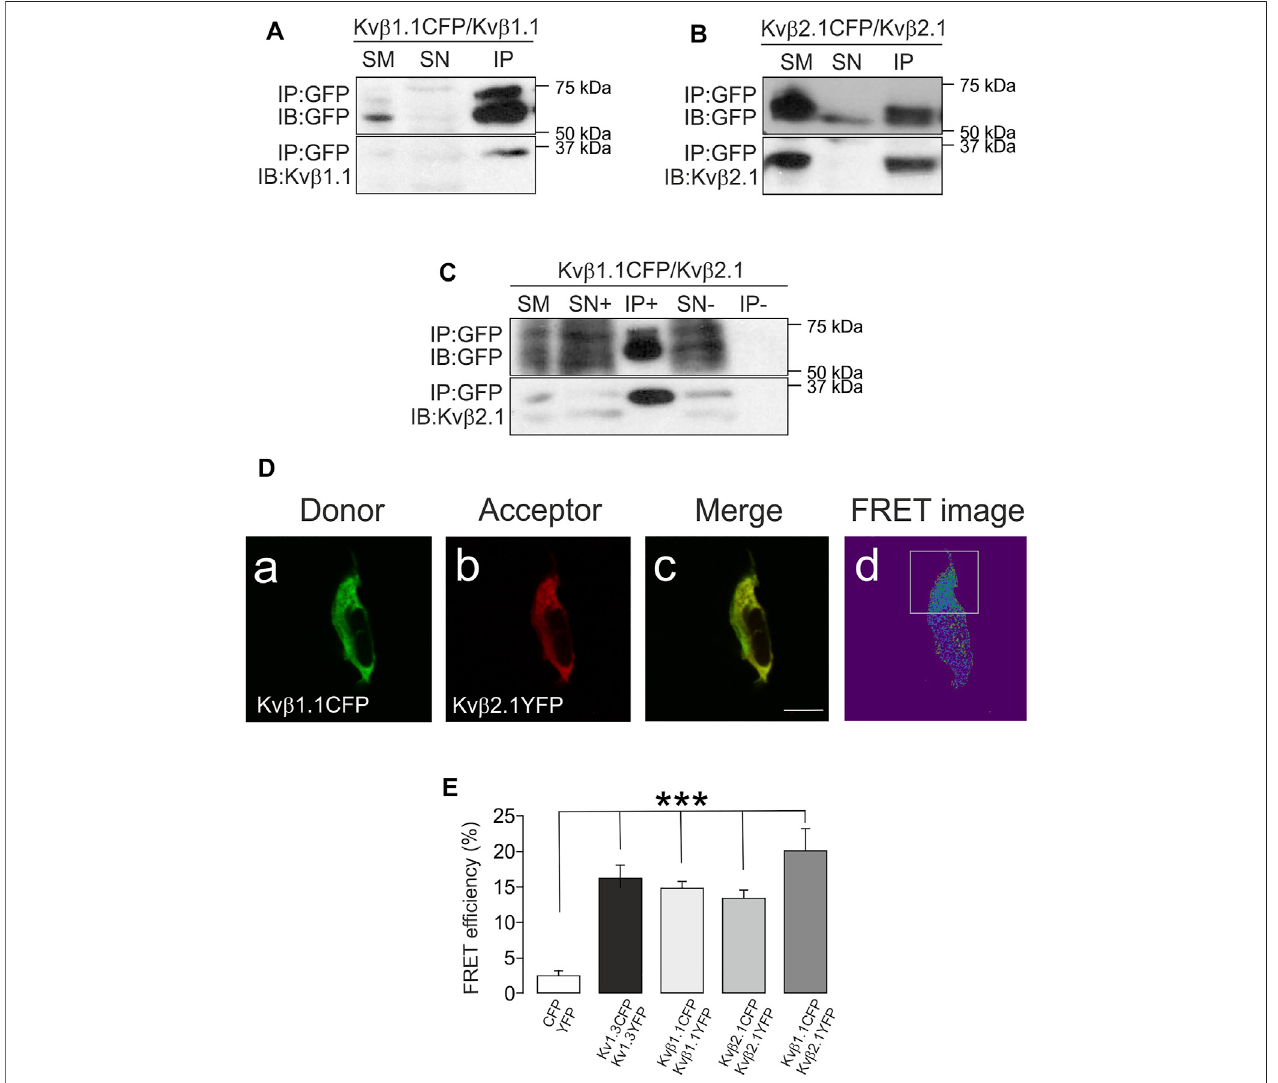
FIGURE 2 | Kv β 1.1 and Kv β 2.1 form oligomers. HEK 293 cells were transfected with Kv β 1.1 and Kv β 2.1. (A) Coimmunoprecipitation assay against Kv β 1.1CFP in the presence of Kv β 1.1. (B) Coimmunoprecipitation assay against Kv β 2.1CFP in the presence of Kv β 2.1. (C) Coimmunoprecipitation assay against Kv β 1.1CFP in the presence of Kv β 2.1. (C) . Top panels: immunoprecipitation (IP) of CFP and immunoblot (IB) against CFP. Bottom panels: IB against Kv β 1.1 (A) and Kv β 2.1 (B , C) . SM: starting material. SN+: supernatant in the presence of the antibody. IP+: Immunoprecipitation in the presence of the antibody. SN-: supernatant in the absence of the antibody. IP-: immunoprecipitation in the absence of the antibody. (D) Kv β 1.1 and Kv β 2.1 form homo- and hetero-oligomers. Representative image of Kv β 1.1 and Kv β 2.1 cotransfection. (Da) Donor, Kvb1.1CFP; (Db) Acceptor, Kvb2.1 YFP; (Dc) merge, yellow indicates colocalization; (Dd) FRET image obtained from the relationship between the donor prebleach versus postbleach after acceptor photobleaching. The white square highlights the bleached section. The bar represents 20 μ m. (E) FRET ef fi ciencies (%) calculated from the acceptor photobleaching experiments. Values are the mean ± SE of > 30 cells. *** p < 0.01 vs. CFP/YFP negative control (Student ’ s t